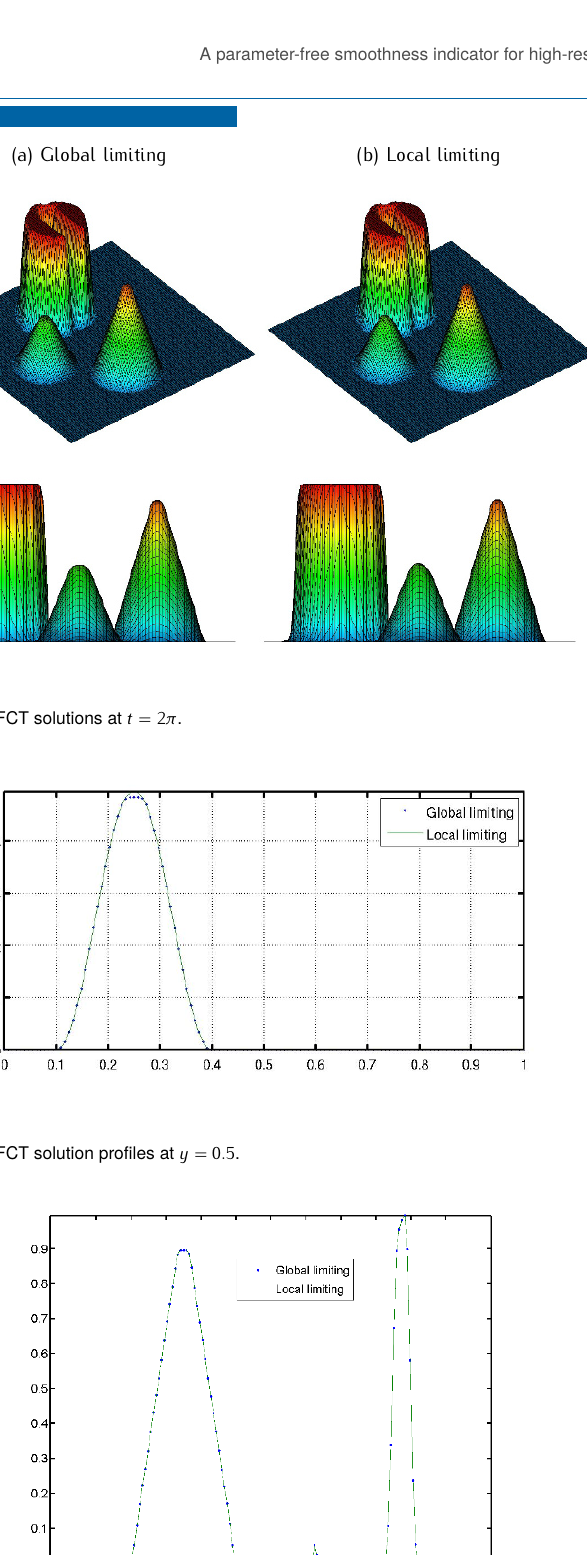
Figure 5. Solid body rotation: FEM-FCT solution profiles at x